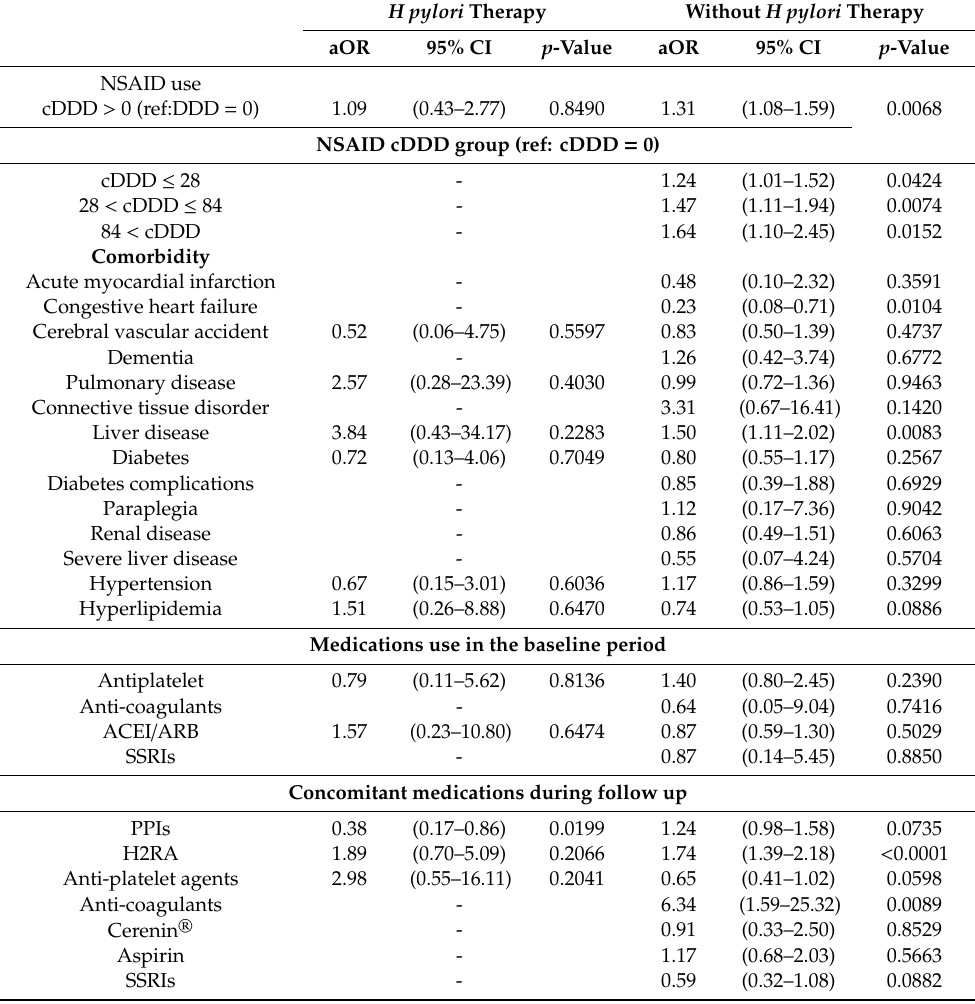
Table 3. Factors associated with recurrent PUD occurrence between with and without H pylori therapy groups in the matched case-control